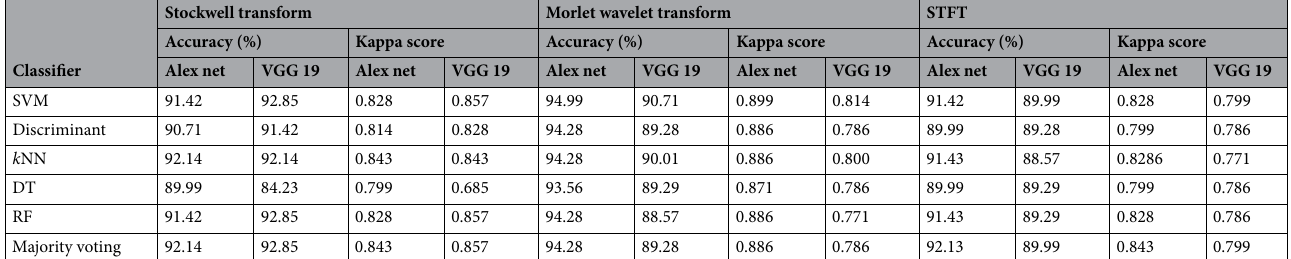
Table 4. Classification accuracy and Kappa scores for different machine learning approaches considering AlexNet and VGG19 networks for Stockwell transform, Morlet wavelet transform and STFT of dataset II–III.